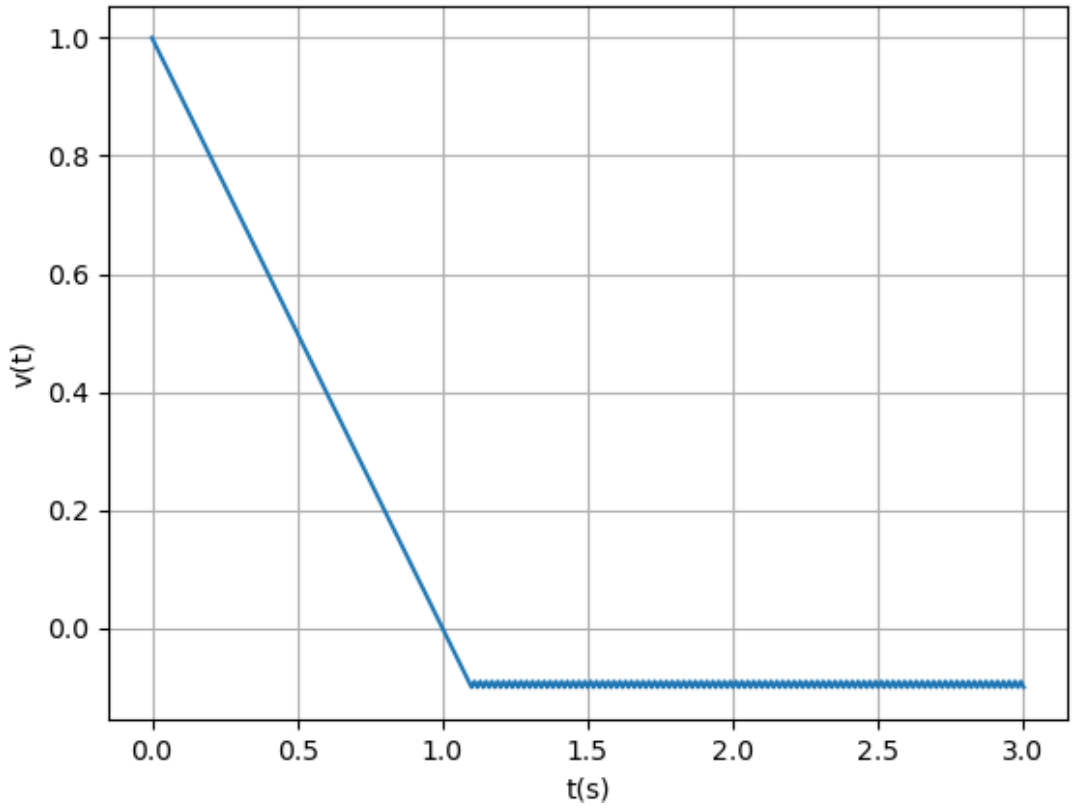
Figure 2. System output